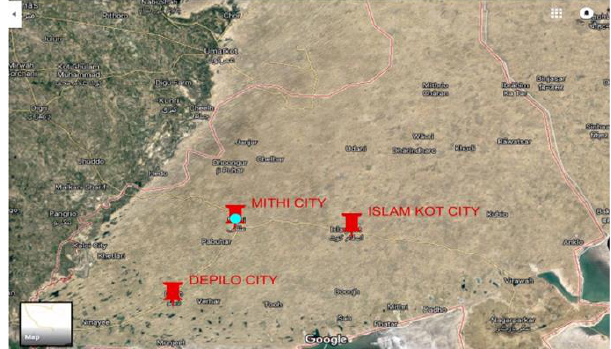
Fig. 2. GIS Map of Mithi, Diplo And Islamkot Cities of